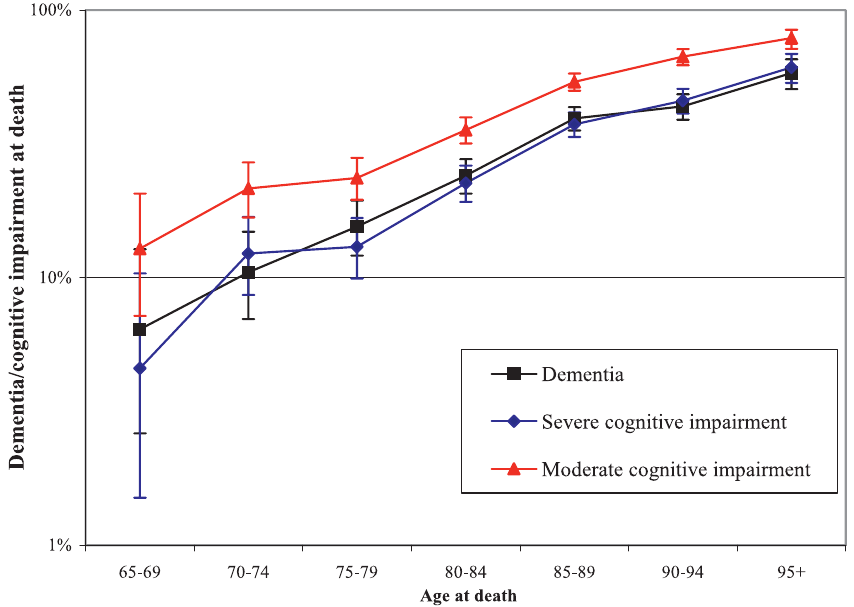
Figure 1. Dementia or Cognitive Impairment by Age at Death with 95% CIs DOI: